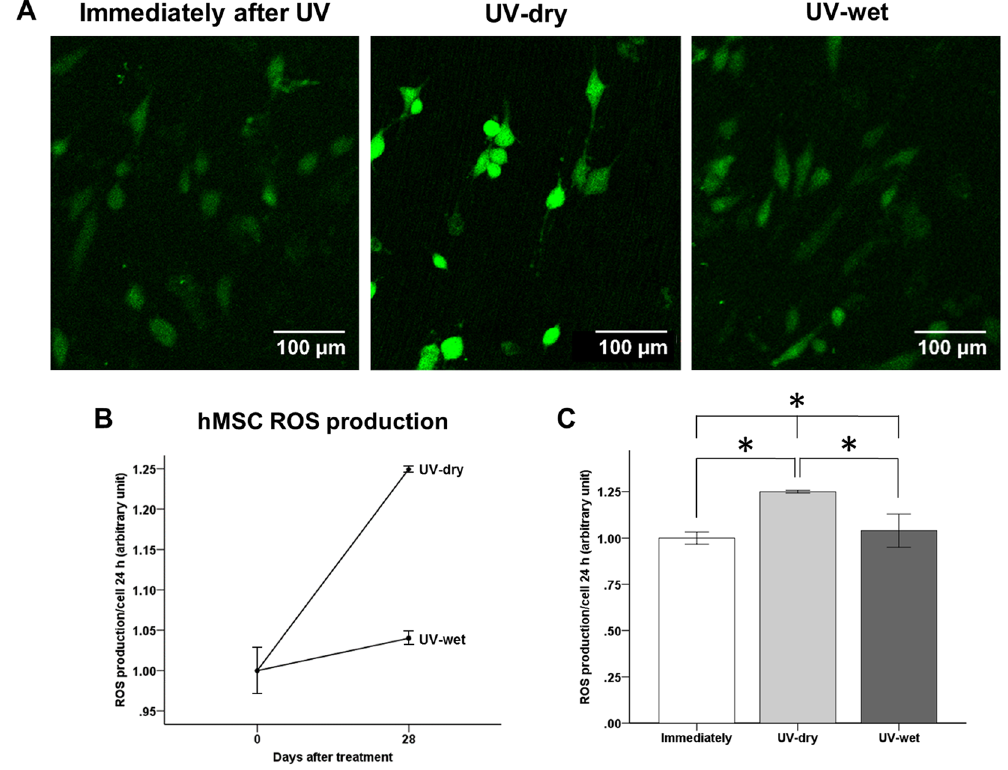
Figure 6. ( A ) Comparison of cellular intracellular reactive oxygen species (ROS) production of hMSC cells after UV treatment, for each group. ( B , C ) Comparison of intensity of intracellular ROS signal after UV treatment, for each group. * P < 0.05 for comparisons between